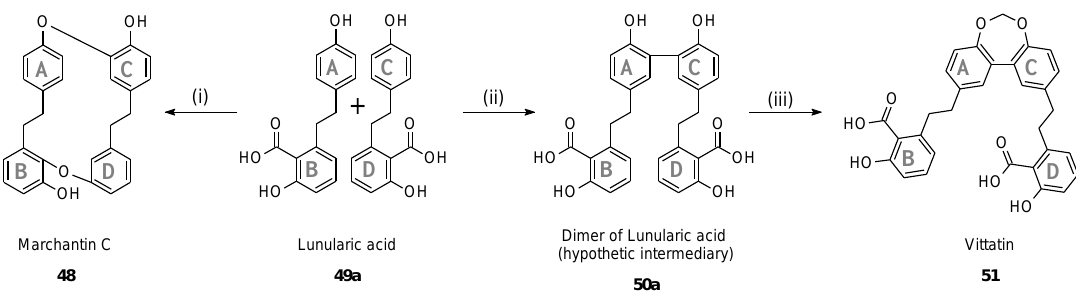
Figure 6. Putative biosynthesis pathway of vittatin ( 51 ), (i): marchantin C synthase; (ii): biaryl coupling; (iii): methylenedioxy formation.